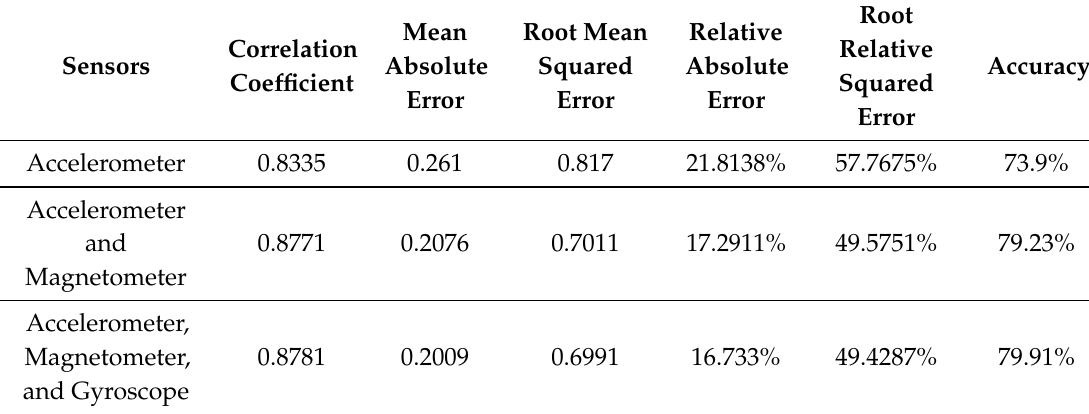
Table 2. ADL recognition using the Instance Based k-nearest neighbour (IBk) method implemented with Weka